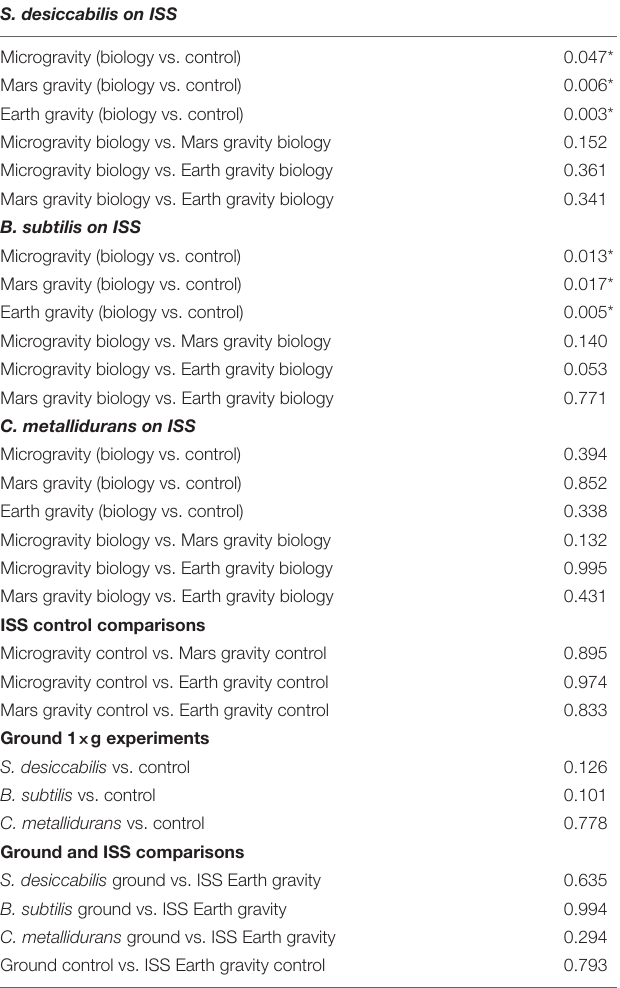
TABLE 2 | Student’s t -test comparisons ( p -values) between vanadium leaching in selected treatments. S. desiccabilis on ISS Microgravity (biology vs. control) 0 . 047 * Mars gravity (biology vs.